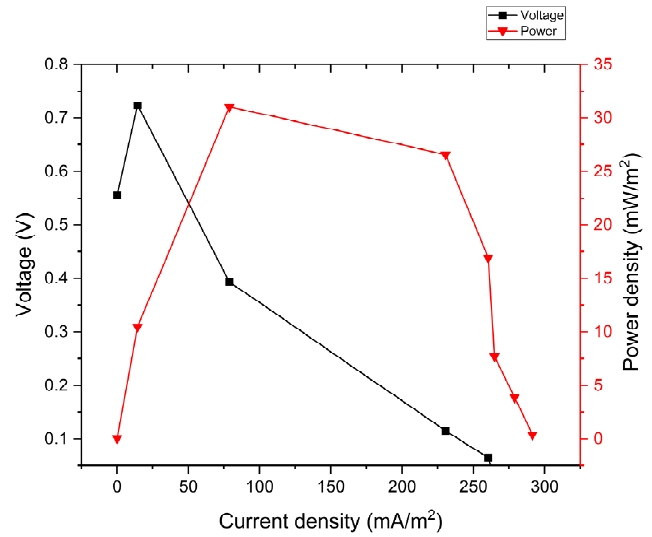
Figure 8. Measurement of polarization curves of the MFC by Citrobacter sp. Av_G1.